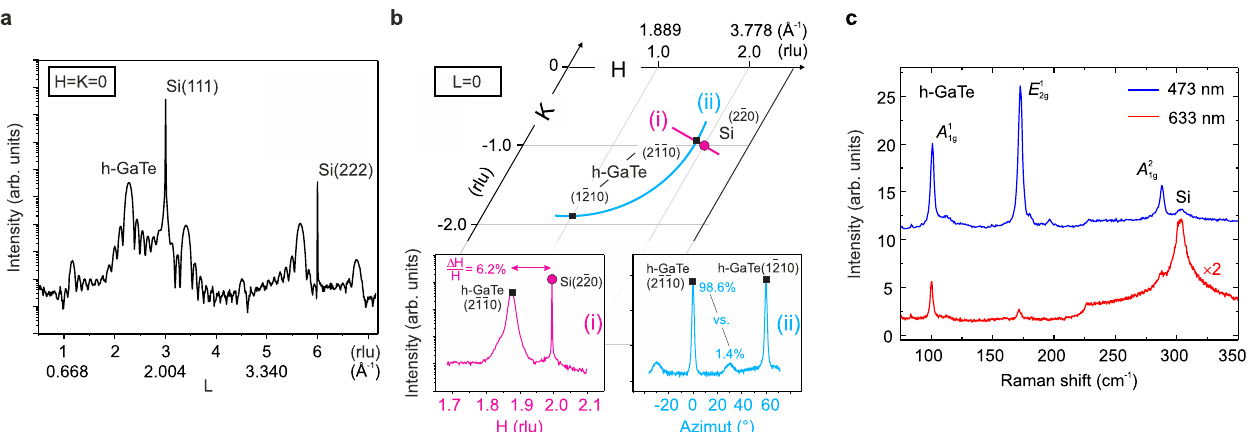
Fig. 2 Synchrotron-based X-ray diffraction and Raman spectroscopy for 9 nm (11 ML) thick epitaxial h-GaTe fi lm capped with ZnS/SiO 2 . a Symmetric out-of-plane ω -2 θ scan probing exclusively vertical lattice properties of the sample. The coordinates are given in reciprocal lattice (cid:2) 1 . b Area in reciprocal space at L = 0 as accessible through units (rlu) and the corresponding absolute lengths of the scattering vector Q in _ A GID. This refers exclusively to in-plane lattice properties. There are two scanning directions shown: (i) a radial scan along the GaTe[ 2110 ] (magenta) and (ii) an azimuthal distribution (cyan) intersecting symmetrically equivalent GaTe peaks. c Raman spectra showing the main h-GaTe and the Si phonon modes with a 473 nm (blue) and a 632.8 nm (red) laser